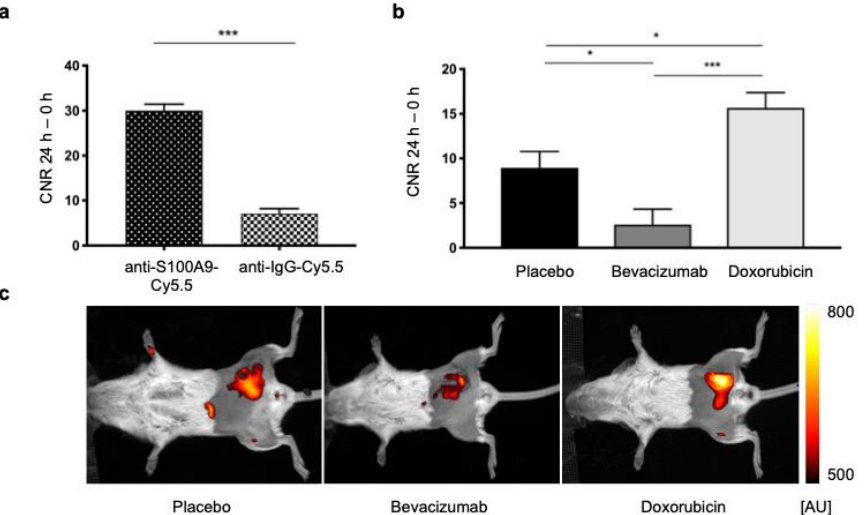
Figure 2. S100A9-specific in vivo Fluorescence Reflectance Imaging. ( a ) Validation of the S100A9- probe´s specificity: ( b ) Comparison of CNR after treatment (second in vivo imaging): Compared to placebo, fluorescence intensities under Doxorubicin were significantly higher ( p = 0.01) and under Bevacizumab significantly lower. Furthermore, significant differences between the Bevacizumab and the Doxorubicin group were detected. ( c ) Exemplary fluorescence reflectance imaging (FRI) images (overlay of white light and fluorescence images) 24 h after probe injection. The visual comparison of the fluorescence intensities correlates with the measured values shown in ( b ). Asterisks indicate significance: * p < 0.05, *** p < 0.001.